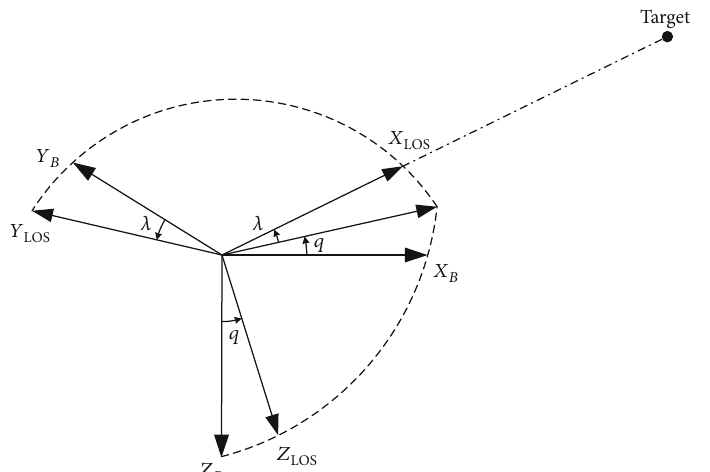
Figure 4: Relation between missile body and LOS